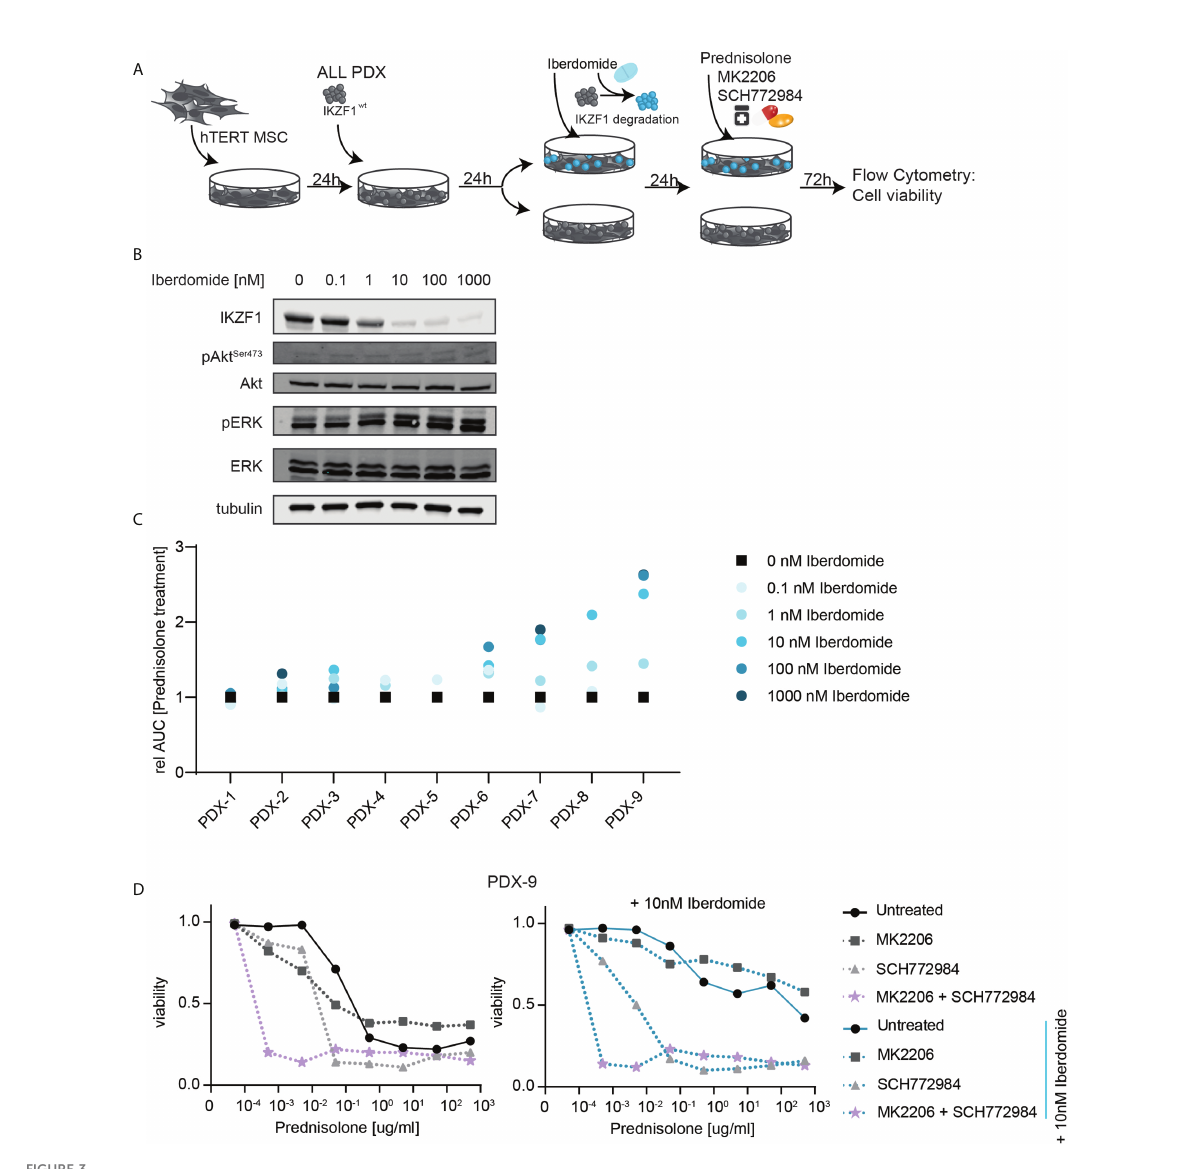
with previous published data (7) IKZF1 -de fi cient PDXs on average were more resistant to prednisolone compared to PDXs wild type for IKZF1 , albeit with a large variation in sensitivity (Figure 4B).